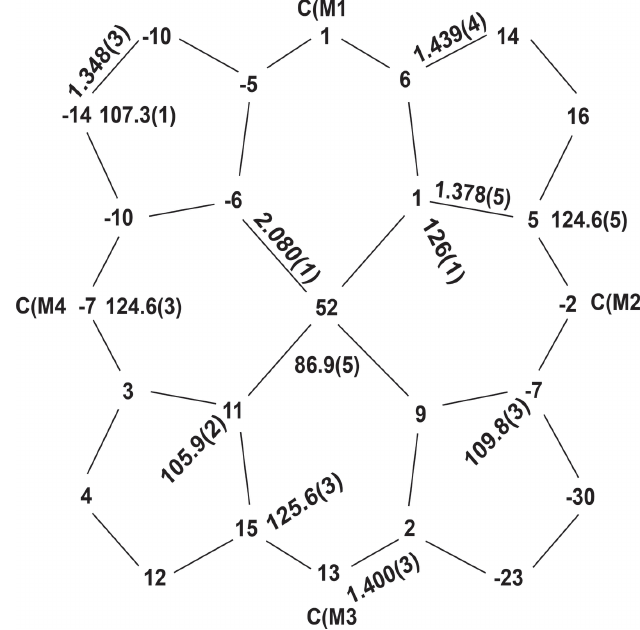
Figure 3 A formal diagram of the porphyrin core of the title compound. Averaged values of the chemically unique bond lengths (A˚ ) and angles ( (cid:2) ) are shown. The numbers in parentheses are the e.s.d.s calculated on the assumption that the averaged values were all drawn from the same population. The perpendicular displacements (in units of 0.01 A˚ ) of the porphyrin core atoms from the 24-atom mean plane are also displayed. Positive numbers indicate a displacement toward the central metal atom.